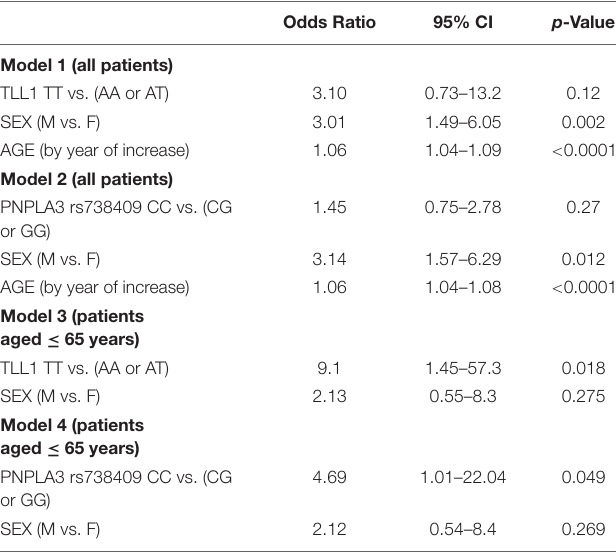
TABLE 5 | Multivariable logistic regression models on risk factors associated with severe outcome (death or critical/intensive care hospitalization). Odds Ratio 95% CI p -Value